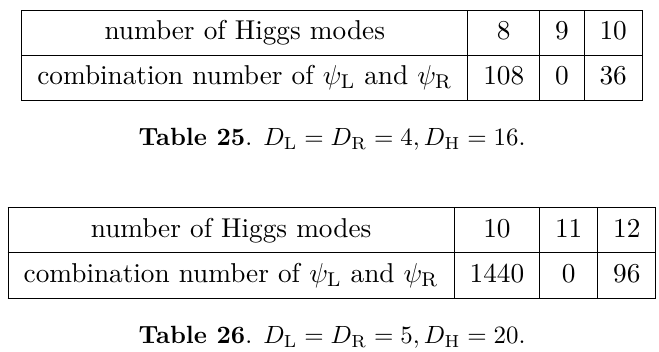
Table 23 . 3 generation of fermion when D = 4 . The mod 2 structures are shown in table 24.